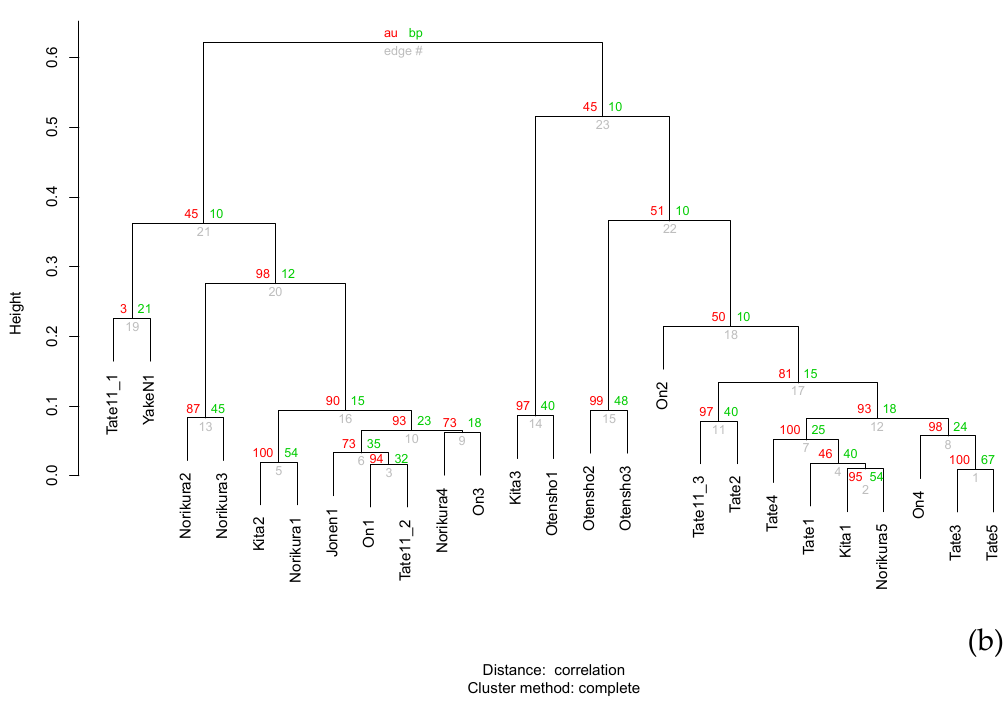
Figure 4. ( a ) Cluster dendrogram at the genus level of cecal microbiota of wild Japanese rock ptarmigans at different locations in Japanese mountains. ( b ) Cluster dendrogram at the family level of cecal microbiota of wild Japanese rock ptarmigans at different locations in Japanese mountains.